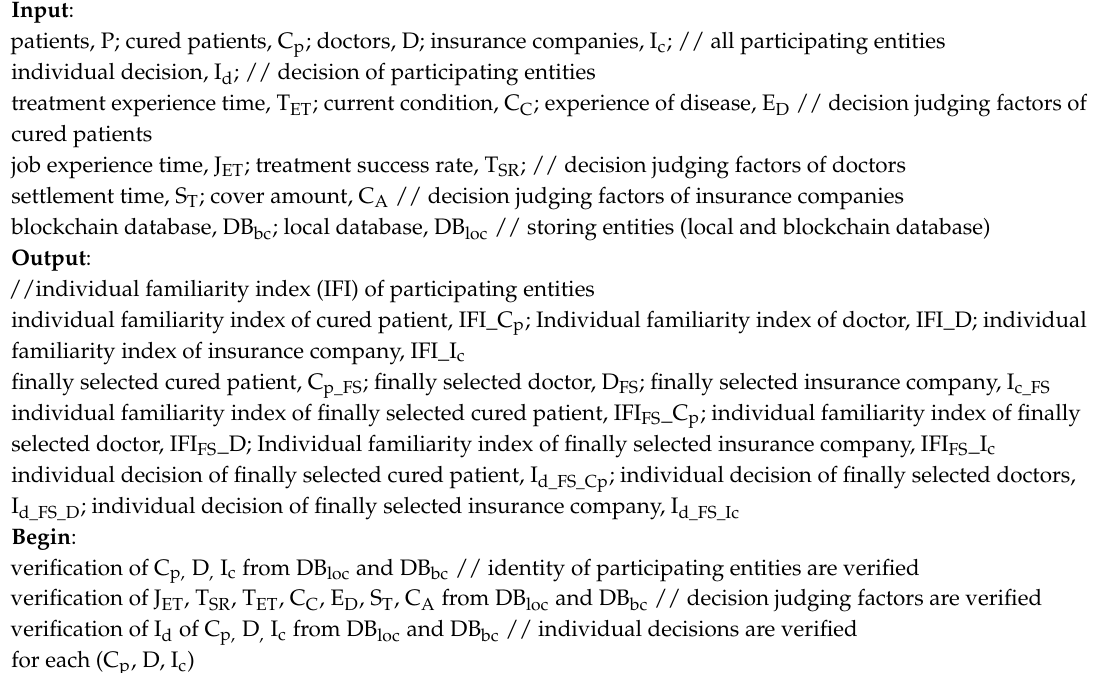
Algorithm 1: Selection of final participating